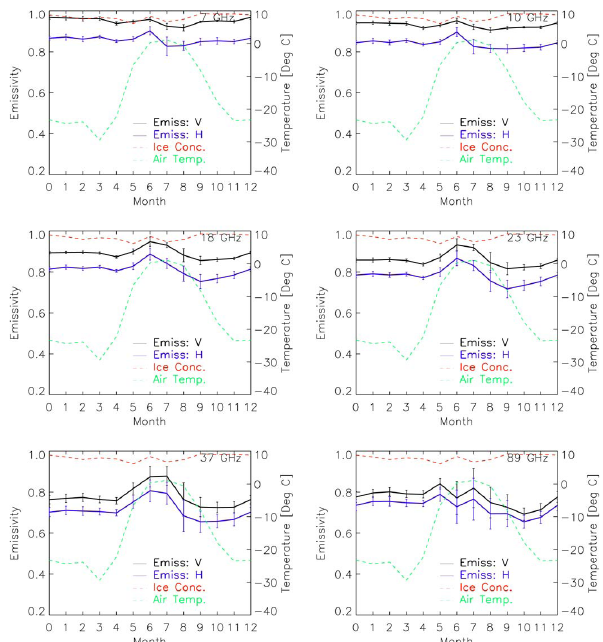
Figure 1. Seasonal variation of emissivities of first-year ice at AMSR-E frequencies, Fig. 1. Seasonal variation of emissivities of first-year ice at AMSR- (black) vertical and (blue) horizontal polarizations. (Top left) 7 GHz, 10 GHz, 18 GHz, 23 GHz, 37 GHz, and (bottom right) 89 GHz. Red dashed line: Ice concentration. Green dashed line: Air E frequencies, (black) vertical and (blue) horizontal polarizations. temperature. Months 0 and 12 are the same. From Matthew et al. (2009). (Top left) 7, 10, 18, 23, 37 and (bottom right) 89GHz. Red dashed line: ice concentration; green dashed line: air temperature. Months 0 and 12 are the same from Matthew et al. (2009).